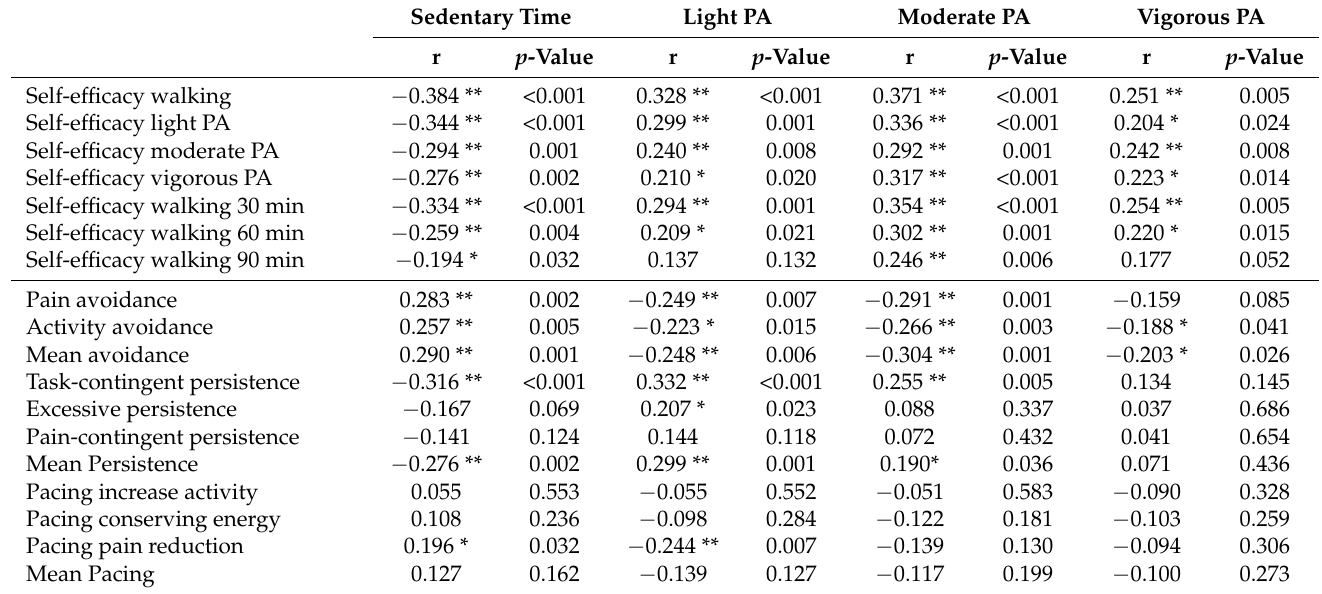
Table 3. Correlations between physical activity levels and self-efficacy and activity